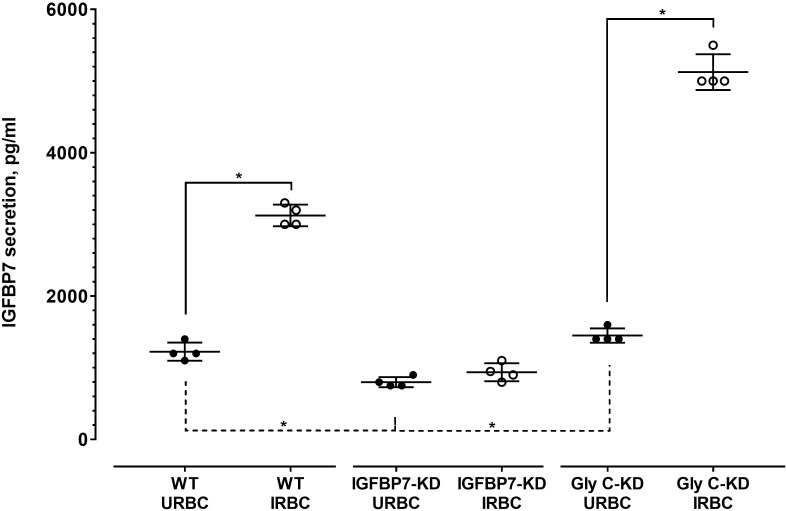
IGFBP7 secretion by THP-1 of different transduction status.Levels of secreted IGFBP7 by THP-1 (1 × 104 cells) of different transduction status 18 h post-incubation with either URBC or P. falciparum 3D7 IRBC. The Mann-Whitney test was used to compare changes between the same cell types, whereas the Kruskal-Wallis test was used for cross-cell type-group comparison. THP-1-WT and GlyC-KD THP-1 showed higher IGFBP7 secretion after IRBC exposure, relative to their URBC-exposed counterparts (p=0.0286 for both groups). IGFBP7-KD THP-1 did not show any significant difference in their IGFBP7 secretion between the URBC-exposed and IRBC-exposed groups (p=0.1429). Among cells exposed to URBC (controls), IGFBP7-KD THP-1 recorded lower values than WT (p=0.0286) and GlyC-KD (p=0.0022). No significant difference was found between WT_URBC and GlyC-KD_URBC (p=0.1928).